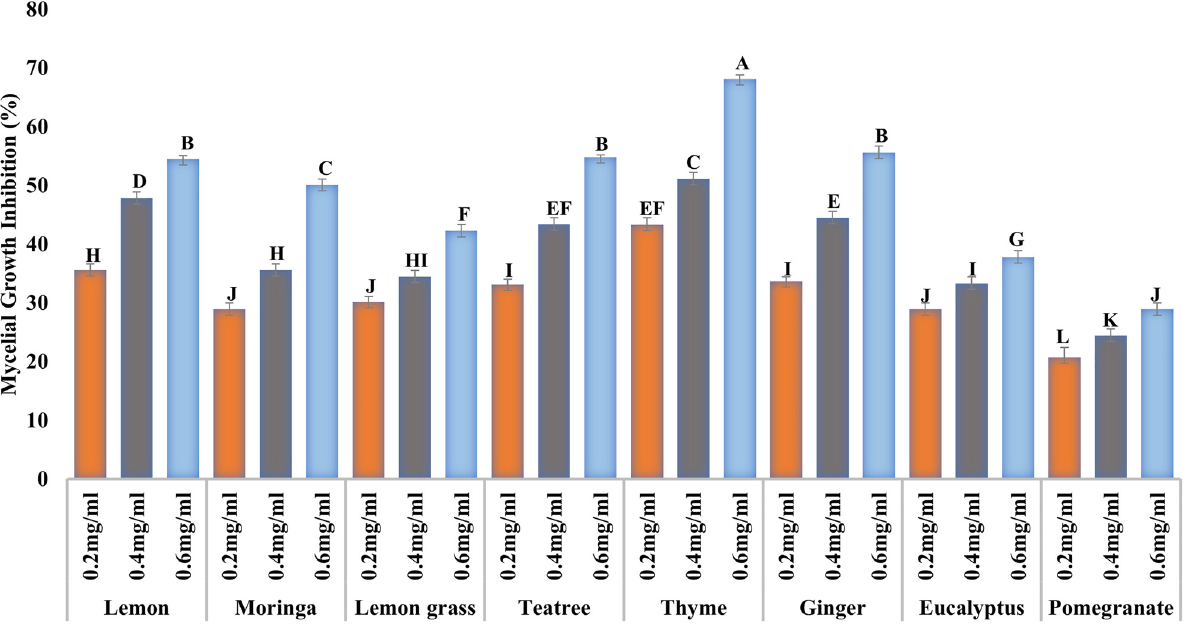
Figure 5: Evaluation of eight selected essential oils against Alternaria alternata in in vitro conditions showing the mycelial growth inhibition (%) of EOs in which thyme oil found most effective against Alternaria alternata . Data with different letters are significantly different according to least significant difference test (p<0.05).